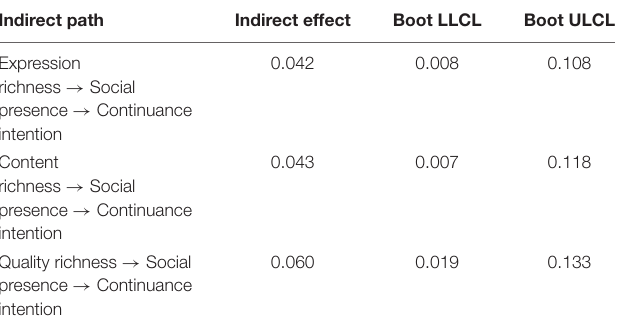
TABLE 5 | Analysis results of mediation effect.